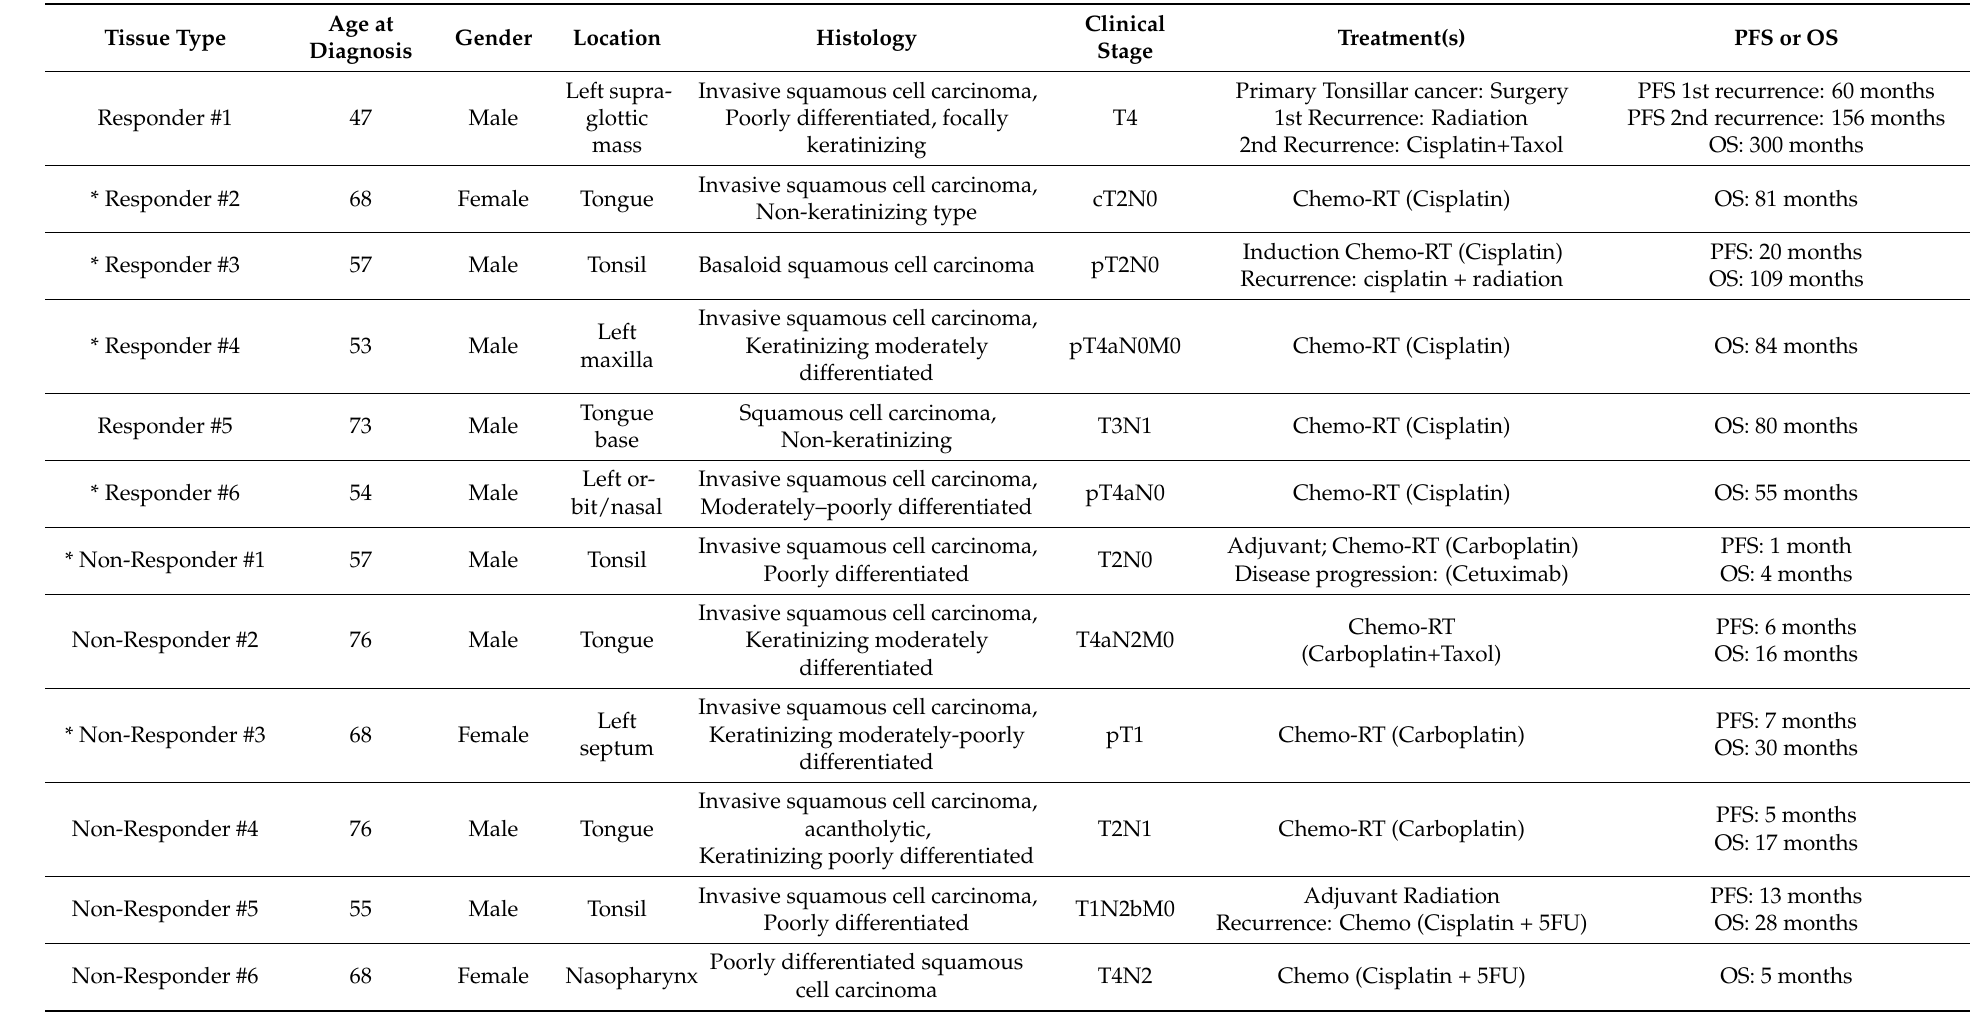
Table 1. Clinical characteristics of HNSCC